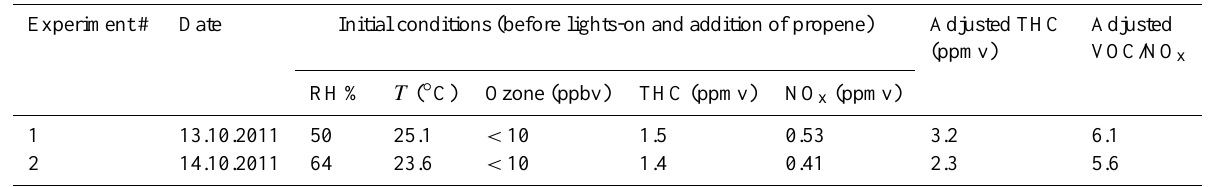
Table 2. Initial and adjusted parameters inside the mobile smog chamber for the gasoline light-duty vehicle aging experiments. Addition of propene after 2h during Exp. 1 and before lights-on for Exp. 2 resulted in adjusted VOC/ NO x ratios of around 6. Experiment # Date Initial conditions (before lights-on and addition of propene) Adjusted THC Adjusted (ppmv) VOC/NO x RH% T ( ◦ C) Ozone (ppbv) THC (ppmv)